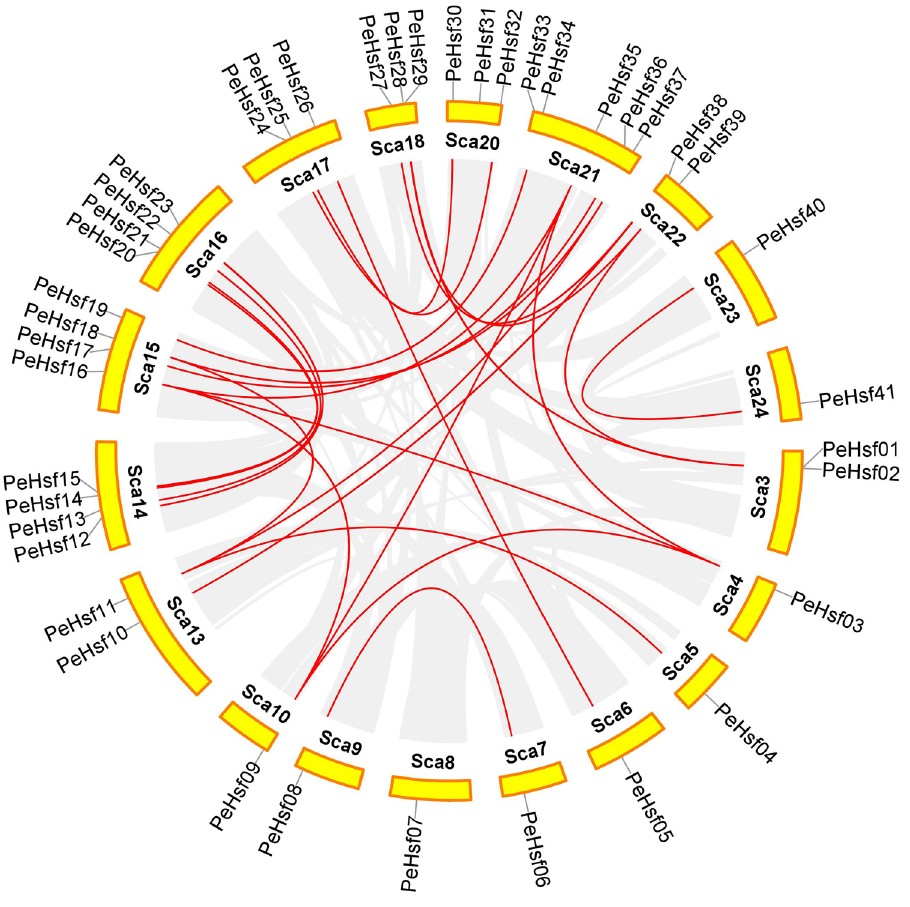
Figure 7. Chromosomal distribution and interchromosomal relationships of PeHsf genes. Gray lines indicate syntenic blocks within the moso bamboo genome, and red lines represent duplicate PeHsf gene pairs. Visualization using Circos in TBtools (v1.0697) (https:// github. com/ CJ- Chen/ TBtoo ls/ relea